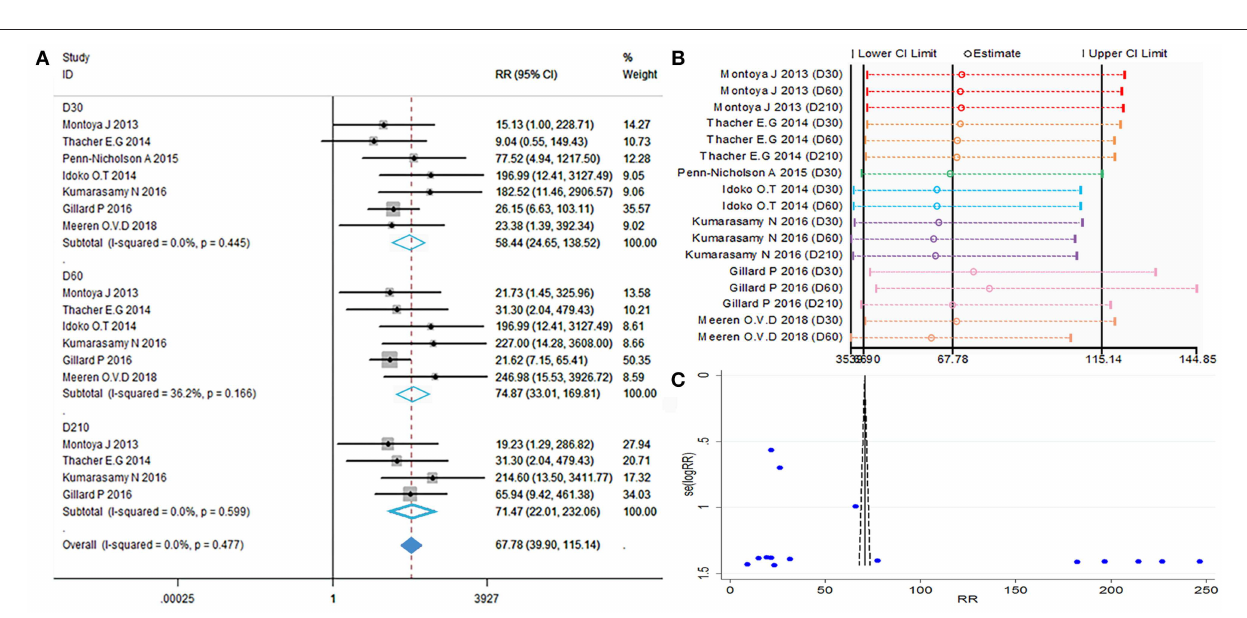
FIGURE 4 | Anti-M72 IgG seropositivity rate. (A) Forest plot: a RR > 1 indicates that the vaccine was protective. RR = 1, invalid result. Point estimates and 95%CI are shown for each study and for the pooled results. (B) Influence analysis, examine the impact of a study on the total combined effect. The vertical solid line in the middle indicates the total combined effect, while the left and right vertical solid lines indicate 95%CI. (C) Funnel plot: the publication bias was independently assessed by determining the symmetrical distribution of the